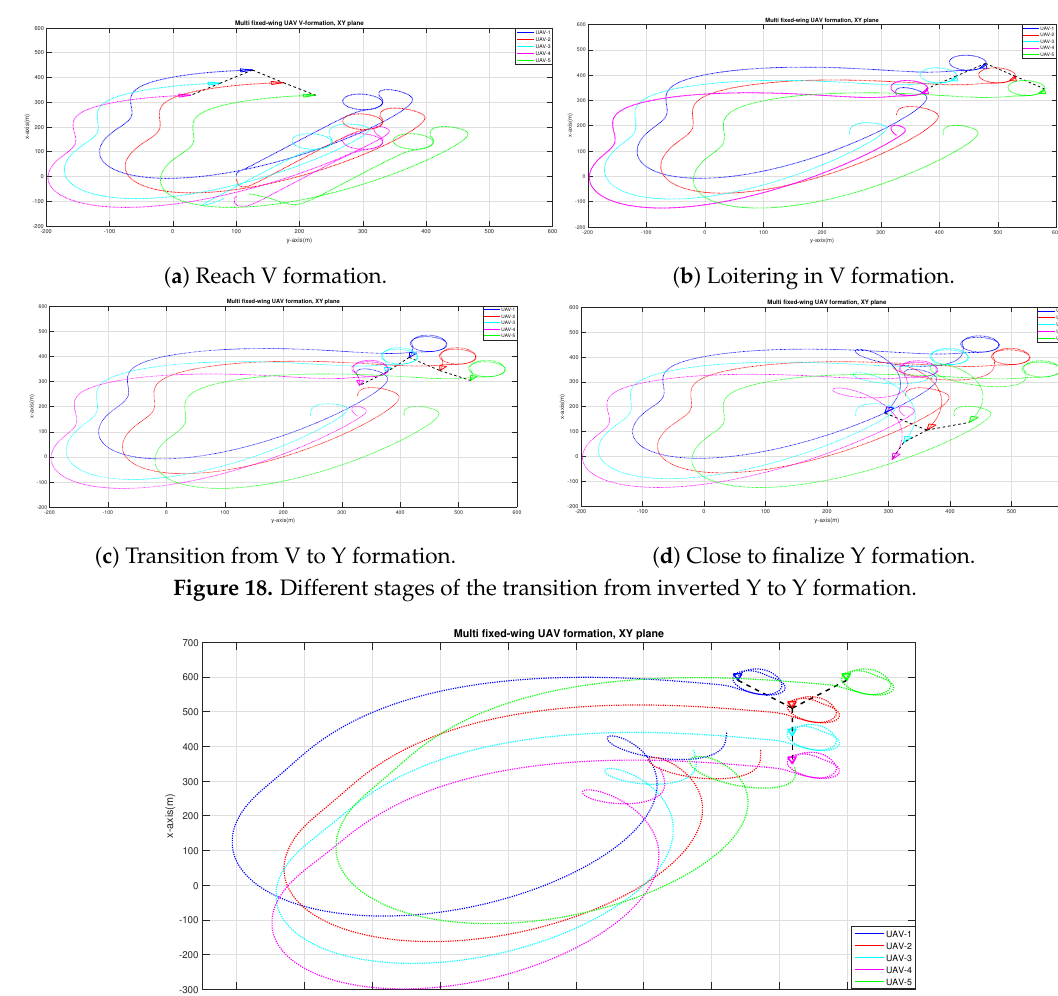
Figure 19. UAVs have completed the transition from V to Y formation and start